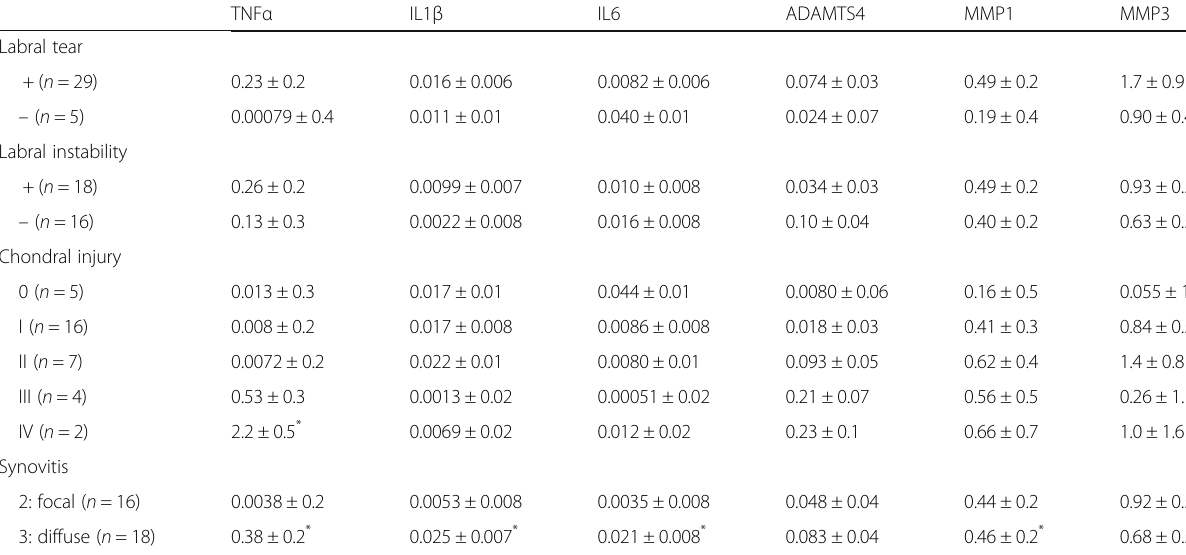
Table 3 Comparison of cytokine levels in patients classified by pathological findings during hip arthroscopy TNF